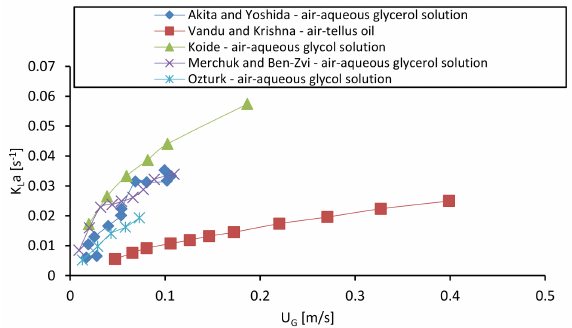
Figure 35. Influence of the operating pressure on k L a —data from Kang et al. [179]—even distribution experimental data.